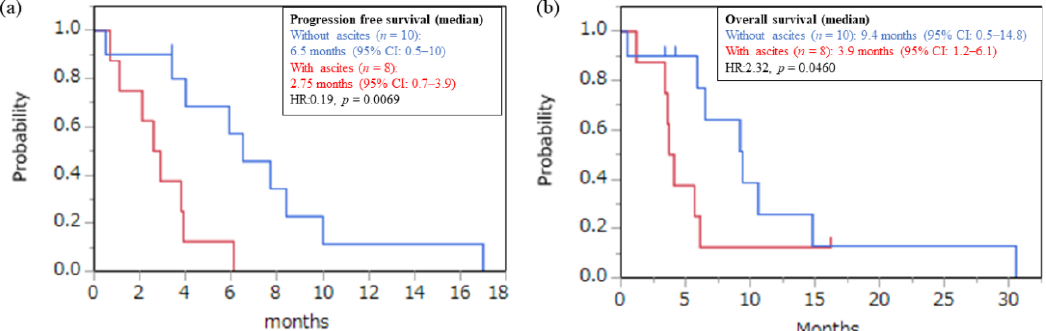
Figure 4. ( a ) PFS and ( b ) OS curve classified by ascites. Red line: with ascites; blue line: without ascites.